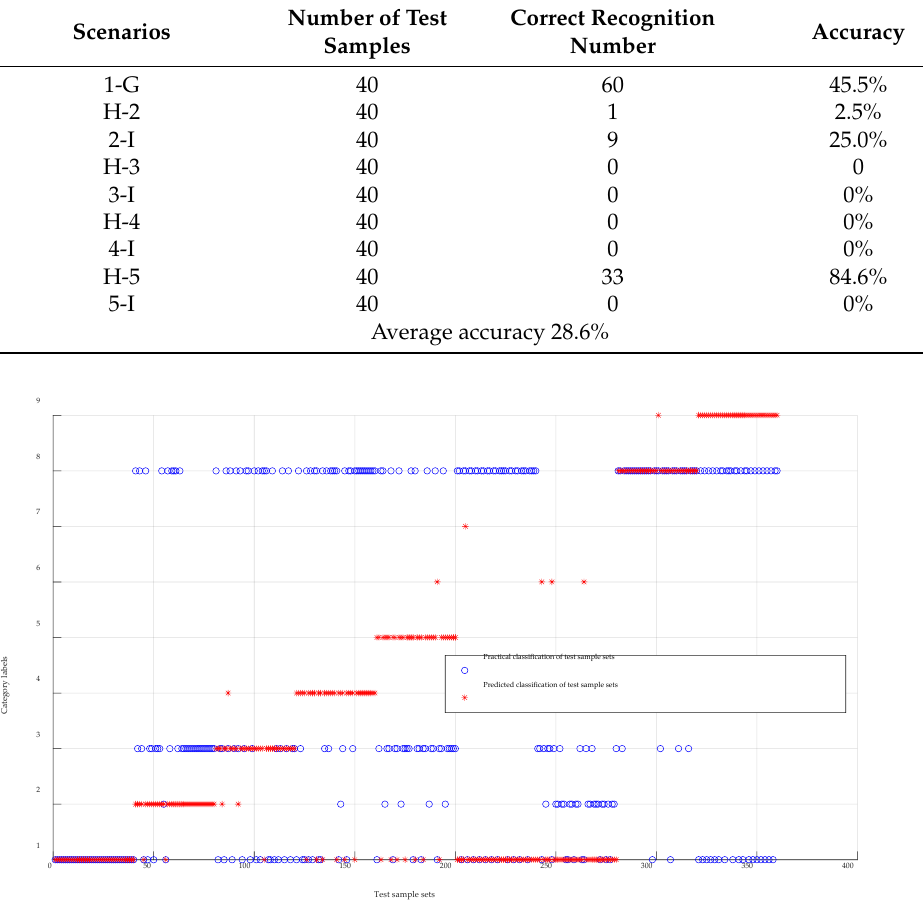
Figure 16. PNN model classification prediction results.